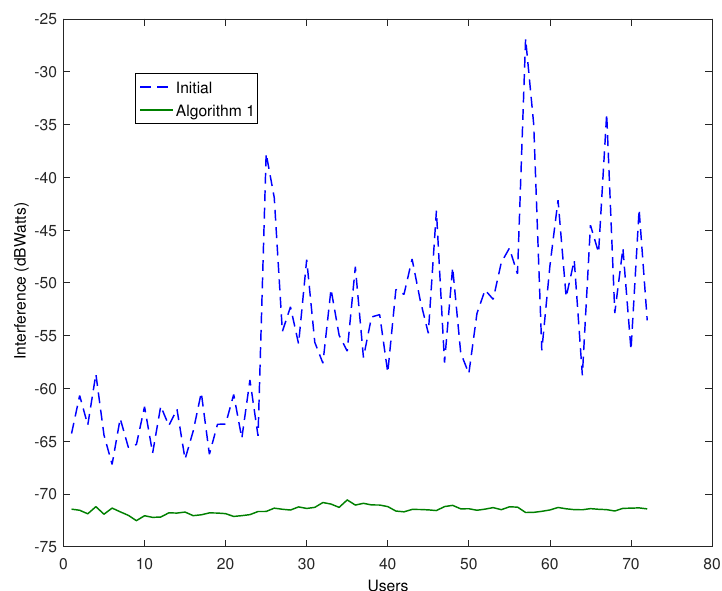
Figure 5. Interference before and after the application of Algorithm 1.